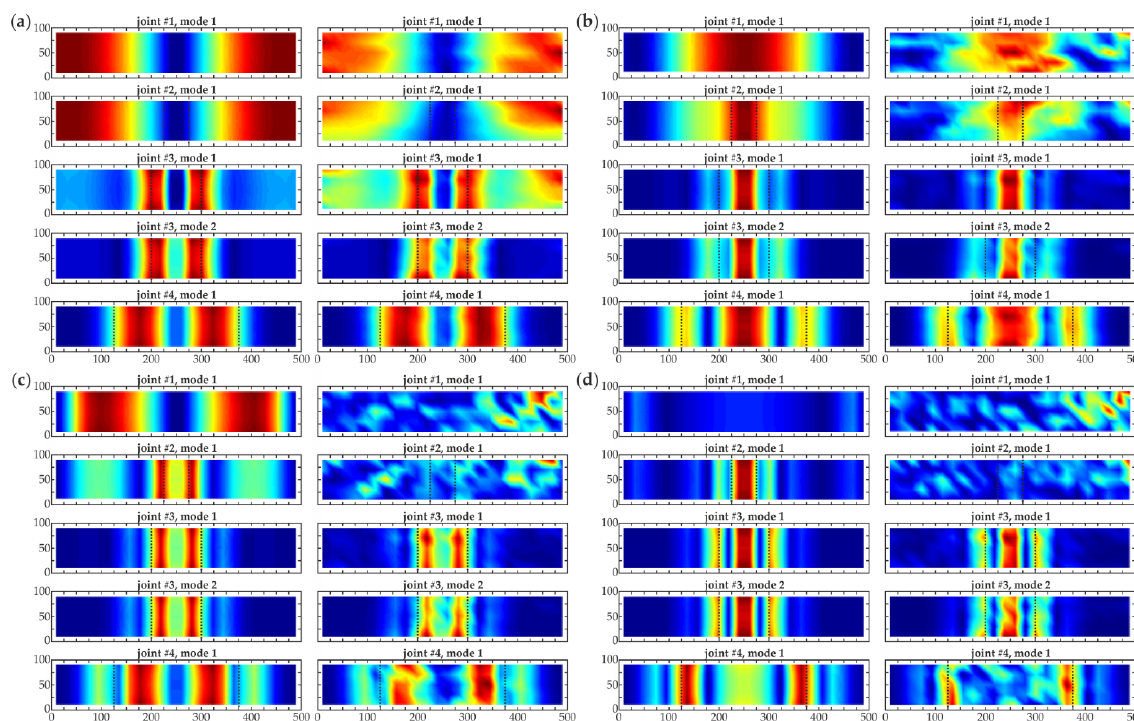
Figure 7. Comparison of CWT damage imaging for numerical (left column) and experimental (right column) results (grid 20 mm, no interpolation) for all joints #1–#4 (dimensions in [mm], scale s = 2) using different wavelets: ( a ) gaus1 ; ( b ) gaus2 ; ( c ) gaus3 ; ( d ) gaus4 .